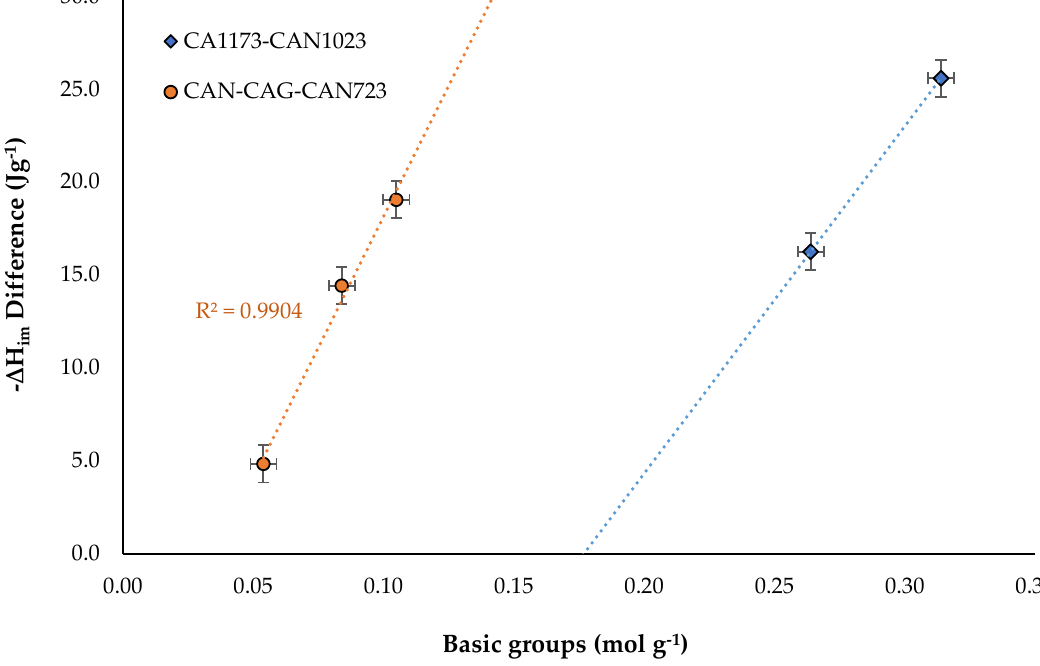
Figure 7. Difference between the immersion enthalpy in cyclohexane and hexane in function of the total basic groups content.